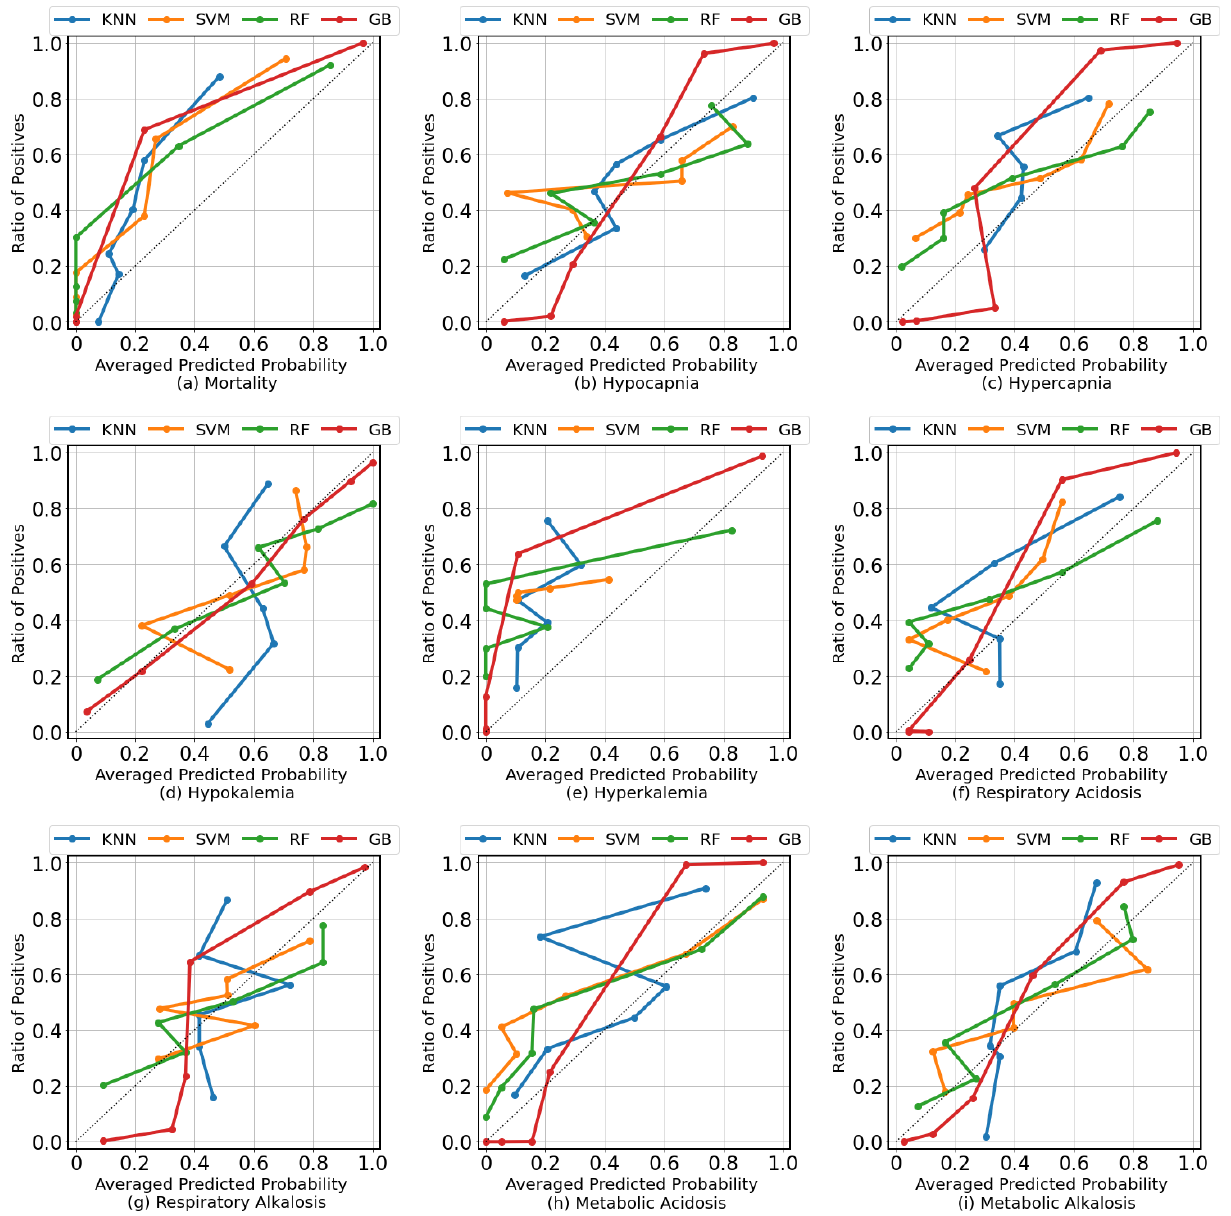
Figure 7. Calibration curves demonstrate the degree of calibration of each classifier for every clinical condition in the test set. Most of the calibration curves indicate that the classifiers are